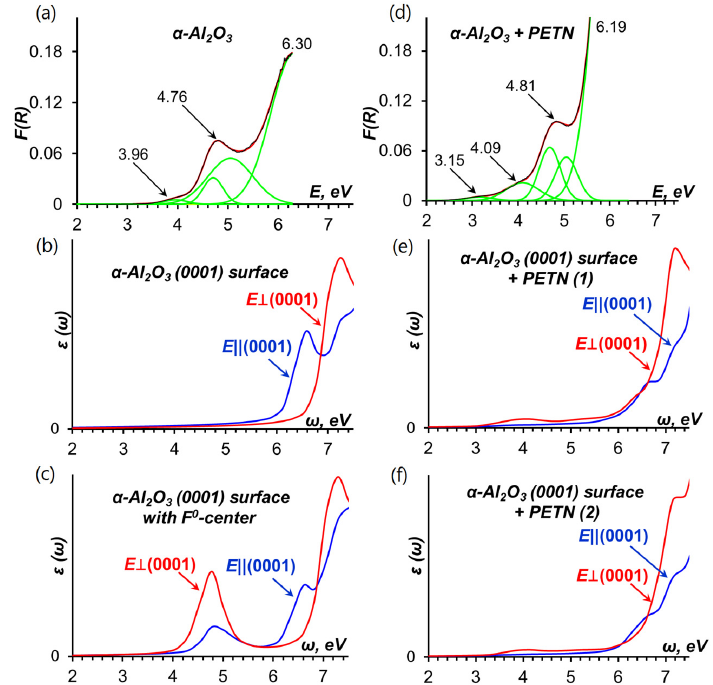
Figure 3. ( a ) Kubelka-Munk function of experimentally measured optical reflectance spectrum of α -Al 2 O 3 ( black line) is approximated with a set of Gaussians ( red line); ( b ) Imaginary part of dielectric function of the pristine (0001) α -Al 2 O 3 surface for light propagation parallel ( blue line) and normal ( red line) to the (0001) direction; ( c ) Imaginary part of dielectric function of the (0001) α -Al 2 O 3 surface containing an F 0 -center for light propagation parallel ( blue line) and normal ( red line) to the (0001) direction; ( d ) Kubelka-Munk function of experimentally measured optical reflectance spectrum of the α -Al 2 O 3 -PETN composite ( black line) is approximated with a set of Gaussians ( red line); Imaginary part of dielectric function of (0001) α -Al 2 O 3 surface with PETN molecule adsorbed in ( e ) configuration-1 and ( f ) configuration-2 for light propagation parallel ( blue line) and normal ( red line) to (0001) direction.